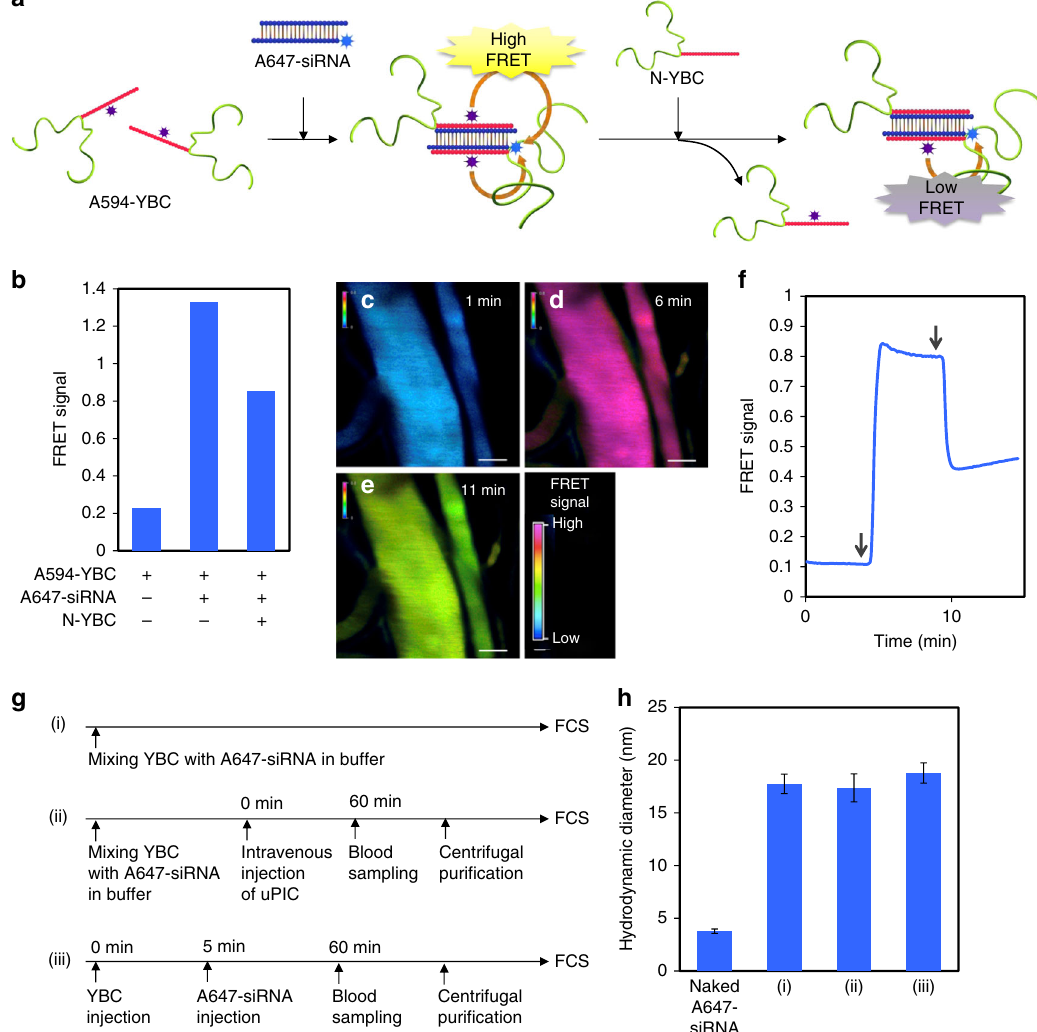
Fig. 2 Dynamic and precise ion-pairing (rendezvous) of an siRNA with free YBCs. a Schematic illustration of the FRET-based analysis of dynamic ion- pairing of siRNA with free YBC (or the exchange reaction between uPIC-forming YBC and free YBC). b FRET analysis of uPIC formation and exchange reaction in buffer solution. c – e IVCLSM images of blood vessels in the mouse ear dermis treated with a stepwise systemic injection of A594-YBC ( c ), A647-siRNA ( d ), and N-YBC ( e ). The scale bars indicate 50 µ m. f Time-dependent changes in the FRET signal obtained by quantitative analysis of the IVCLSM images acquired after A594-YBC injection. Left and right arrows indicate the injection of A647-siRNA and non-labelled YBC (N-YBC), respectively. g Sample preparation scheme for the comparative study of uPIC formation under varying conditions. h Hydrodynamic diameters of A647- siRNA complexed with YBC under varying conditions. Data represent the means ± s.d. for fi ve replicate